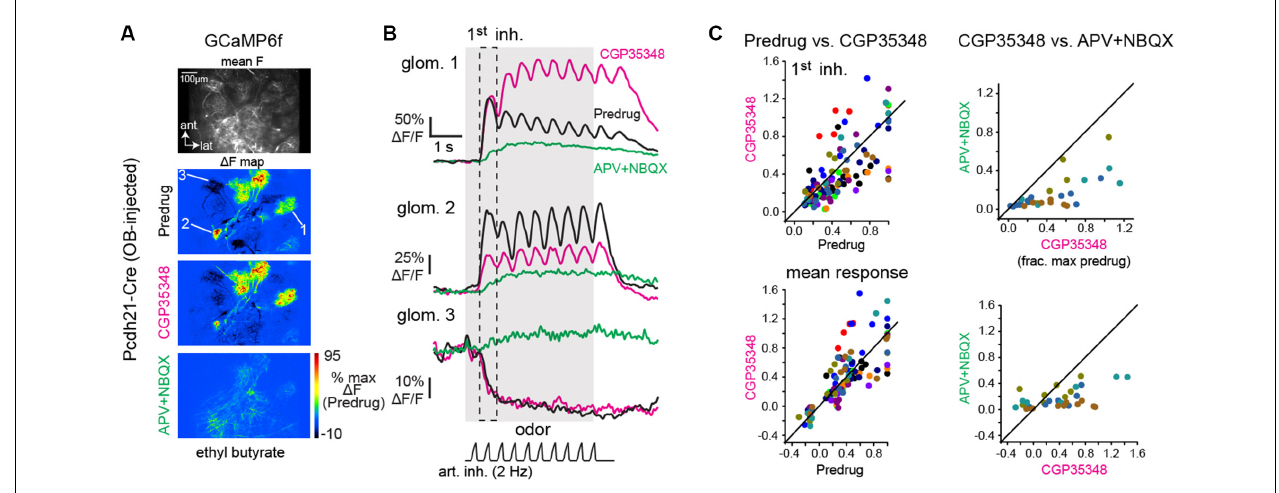
FIGURE 2 | GABA B -mediated presynaptic inhibition has a heterogeneous impact on mitral/tufted cell calcium responses. (A) Baseline fluorescence (mean F) and ∆ F maps of odorant-evoked GCaMP6f signals in mitral/tufted cells, imaged with two-photon microscopy; z-plane is in the deep glomerular layer/outer external plexiform layer of the dorsal OB. Maps show responses to the same odorant (ethyl butyrate) before and after application of CGP35348, and after subsequent application of APV+NBQX. Pseudocolor scale normalized to Predrug response levels. APV+NBQX strongly reduced excitatory responses and eliminated suppressive responses. (B) Response traces for the three glomeruli indicated in (A) , (2 are excited, 1 is suppressed) across each condition. (C) Comparison of mitral/tufted (MT) cell GCaMP6f responses for Predrug vs. CGP35348 conditions (12 mice; left plots) and CGP35348 and subsequent APV+NBQX (four mice; right plots) conditions. Colors indicate individual mice. Top row: peak response amplitudes to the first inhalation of odorant, normalized to the maximum Predrug response in each mouse. Bottom row: mean response across odorant presentation. See Text for CGP35348 summary statistics across mice. For APV+NBQX/CGP35348 statistics, ratios per experiment, reported as medians [quartile range] were: Exp. 1: 0.47 [0.37–0.9], n = 6 ROIs; Exp 2: 0.39 [0.25–0.52], n = 11; Exp 3: 0.38 [0.19–0.57], n = 5; Exp 4: 0.19 [0.08–0.27], n = 6; Full duration: Exp 1: 0.66 [0.46–1.12], n = 6; Exp. 2: 0.4 [0.31–0.51]; Exp 3: 0.37 [0.27–0.50], n = 4; Exp 4: 0.12 [0.05–0.18], n = 7. ROIs were pooled across the four mice for statistical comparison due to the small number of ROIs in each